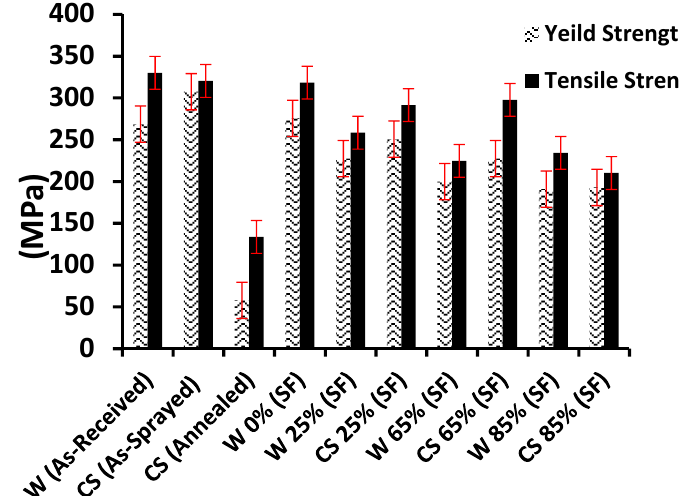
Figure 10. Tensile data for wrought (W) and cold-sprayed (CS) samples at various pre-stress levels after 90 days of B-117 salt fog exposure (SS).